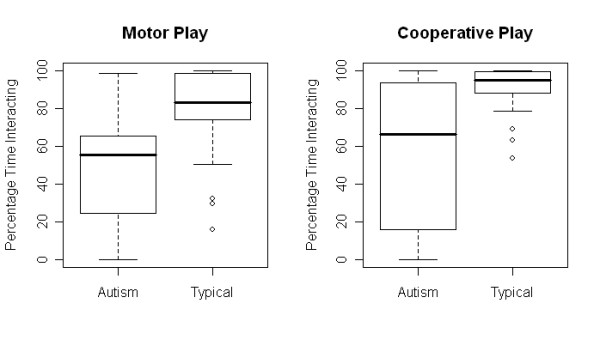
Boxplots of diagnosis and social interaction. Solicited motor play and cooperative play.